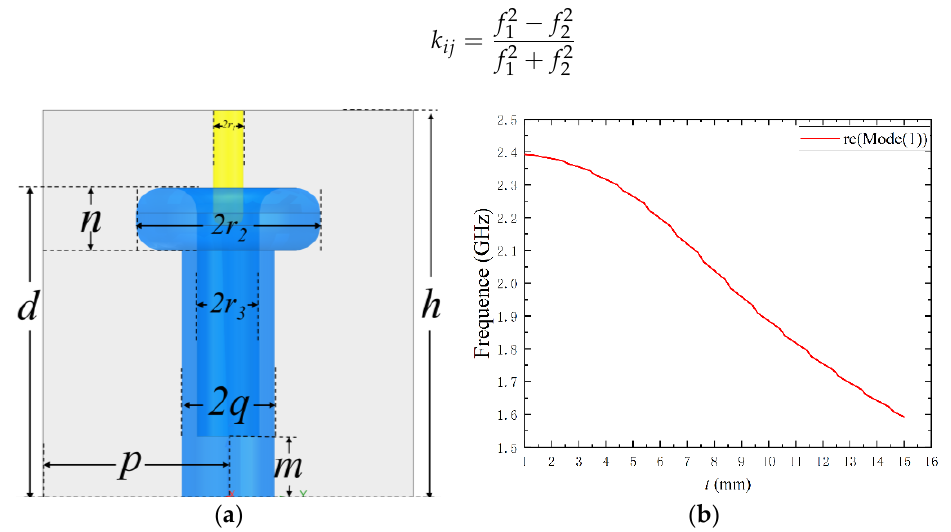
Figure 5. Schematic diagram of ( a ) donut capacitor-loaded resonator ( b ) single-cavity resonance frequency variation with screw length. (Initial dimensions in mm: d = 20, h = 25, m = 4, n = 4, p = 12, q = 3, r 1 = 1, r 2 = 6, r 3 = 2).